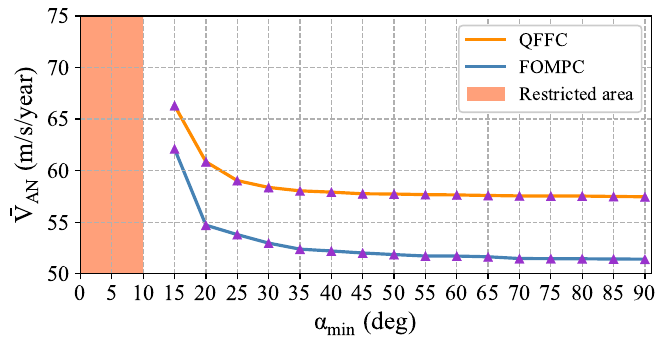
Figure 12. The results of Monte Carlo simulations for α min